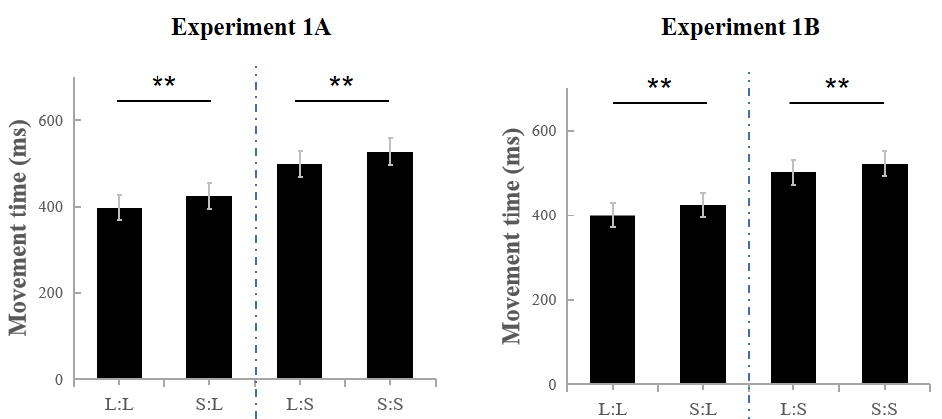
Figure 3. Results of Experiment 1A and 1B. In Exp1A, the movement time of L:L is significantly shorter than that of S:L, and the movement time of L:S is significantly shorter than that of S:S. Similar observations in Exp1B are noted. ** p < 0.01.